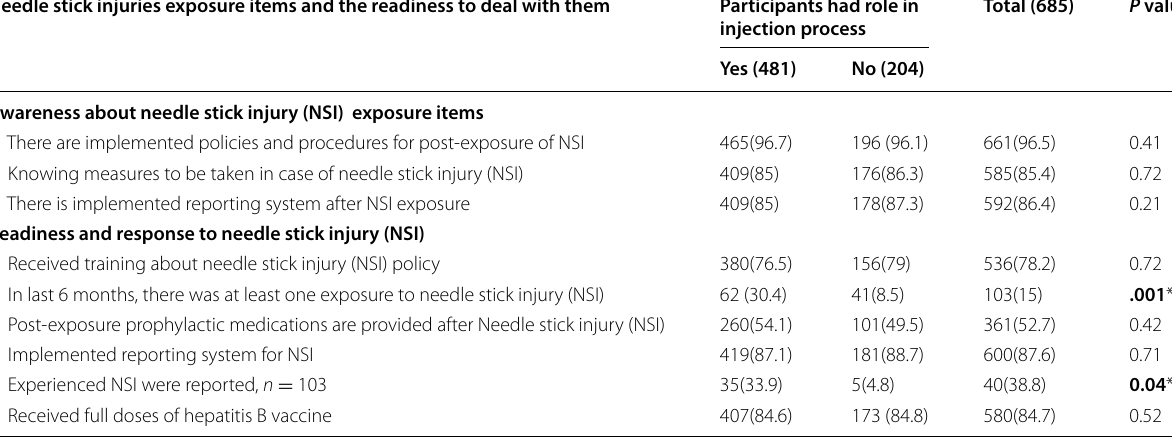
Table 4 Awareness, readiness, and response as regards needle stick injuries exposure among participants according to their role in injection process at Fayoum’s primary health care facilities,